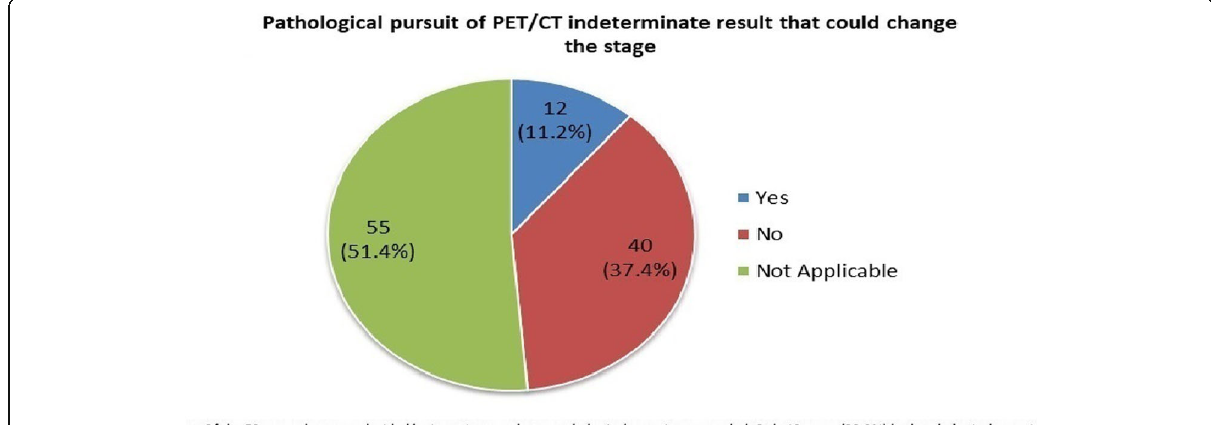
Fig. 5 Pathological pursuit of PET/CT indeterminate result that could change the